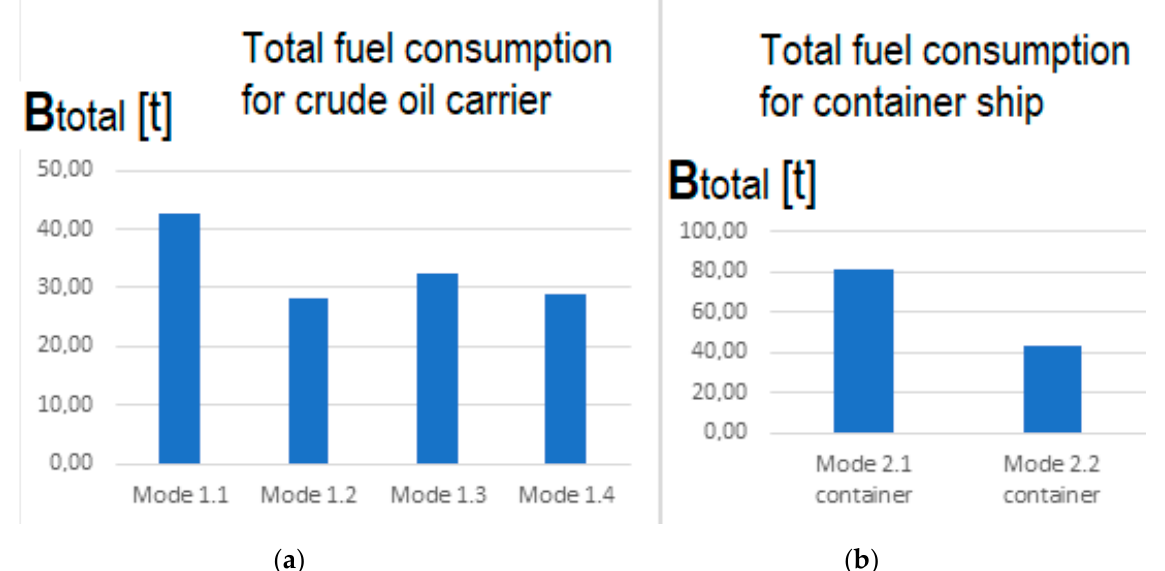
Figure 7. Fuel oil consumptions: ( a ) total fuel consumption for crude oil carrier, ( b ) total fuel consumption for container ship.